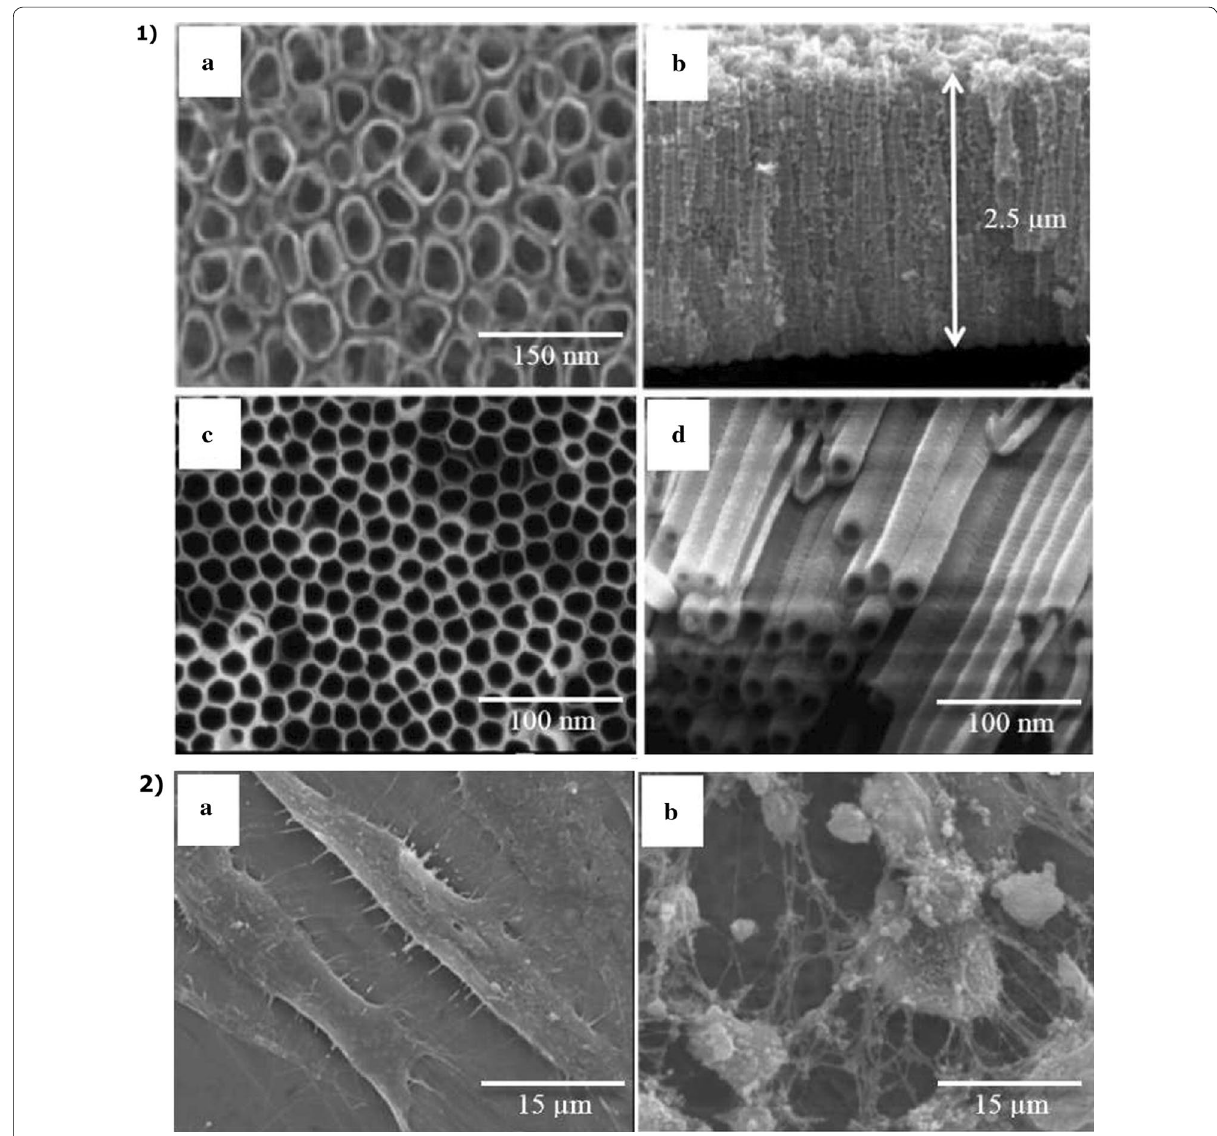
Fig. 2 Alteration in nanotube diameter and morphology only by variation of the solution used and voltage parameters. 1 M solution (NH 4 )